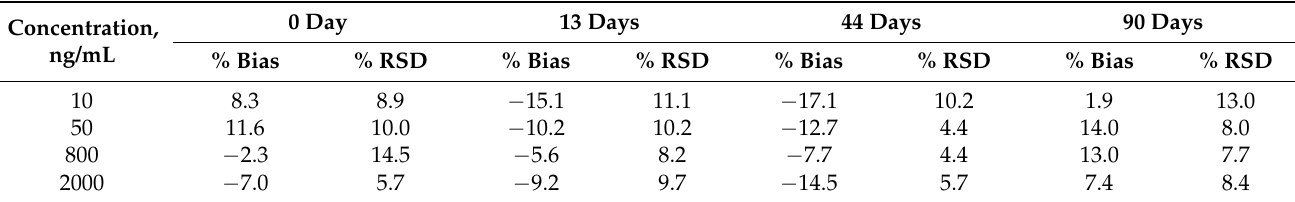
Table 4. Stability of ST-246 in plasma after storage at − 20 ◦ C for 3